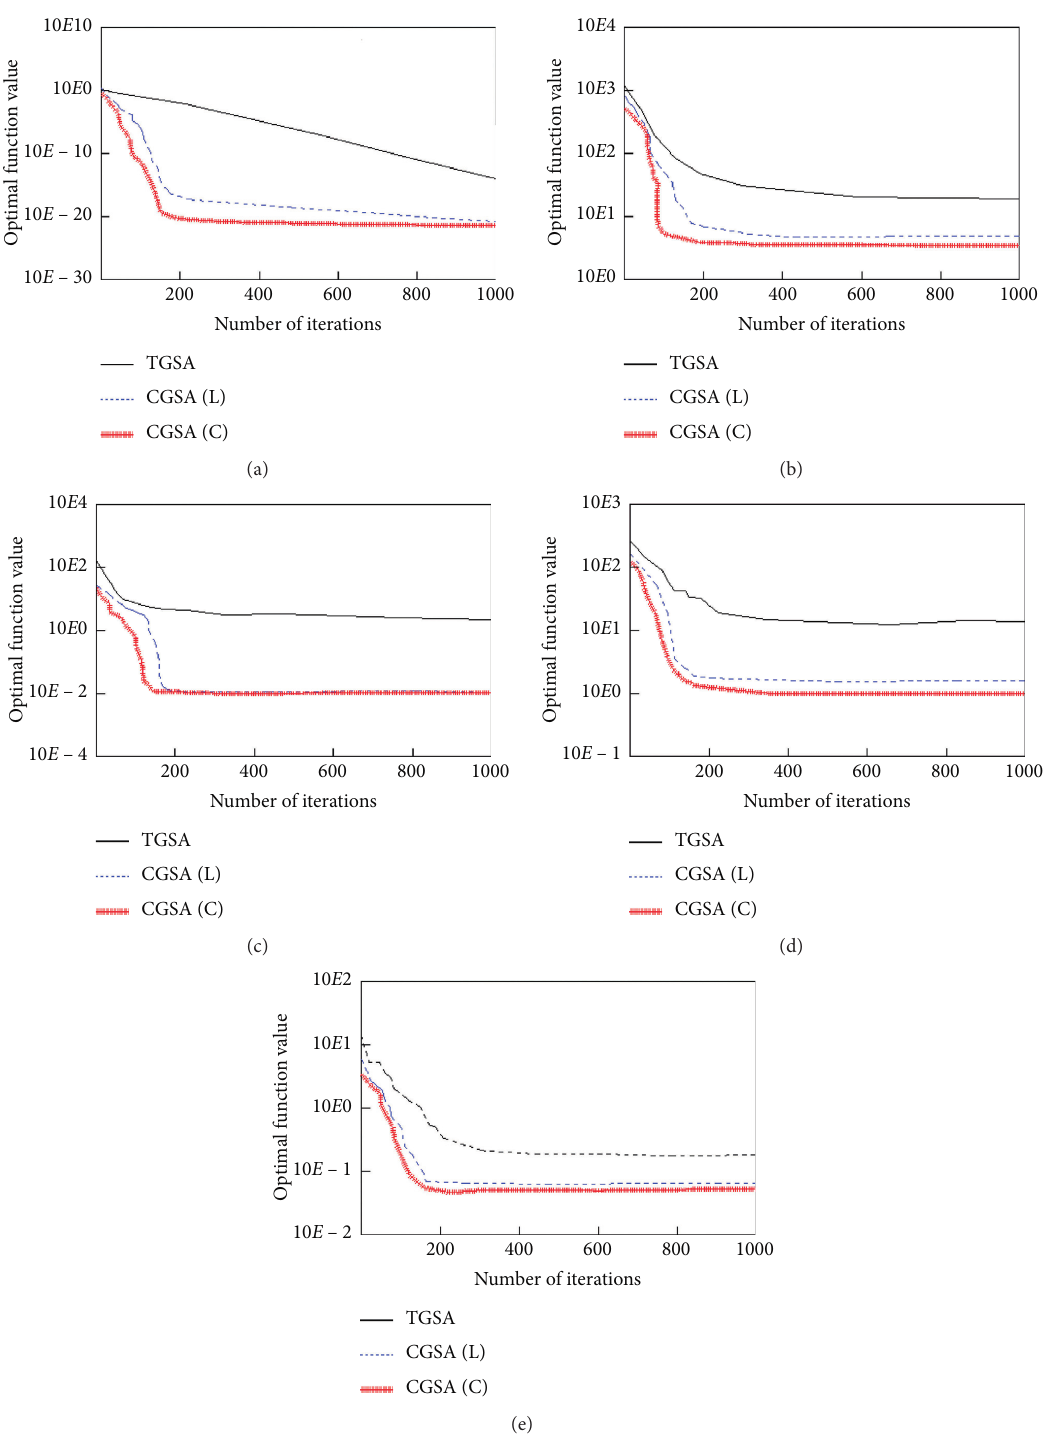
( x ) convergence curves. (b) f 1 ( x ) convergence 5